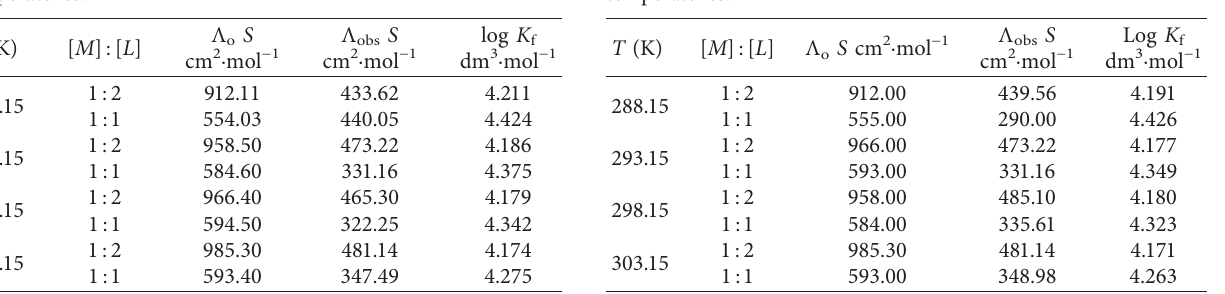
o ) and formation constant